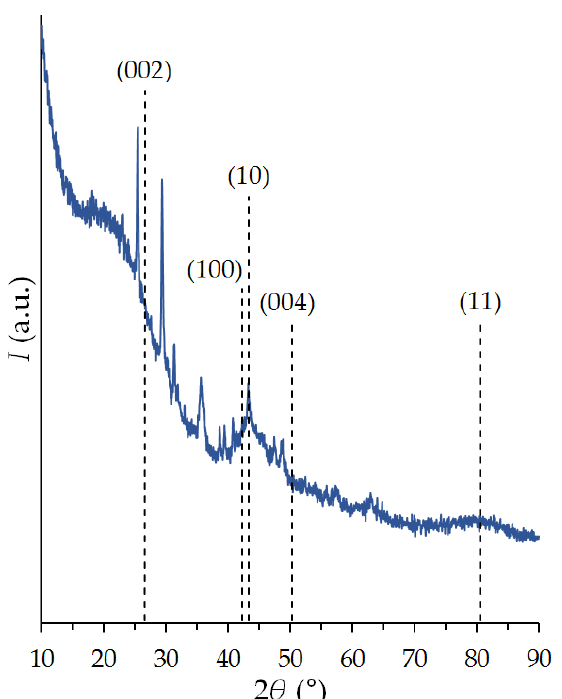
Figure 2. X-ray diffraction pattern of the carbon adsorbent ACPK. Graphite reflections are (002), (10), (100), (004), and (11).